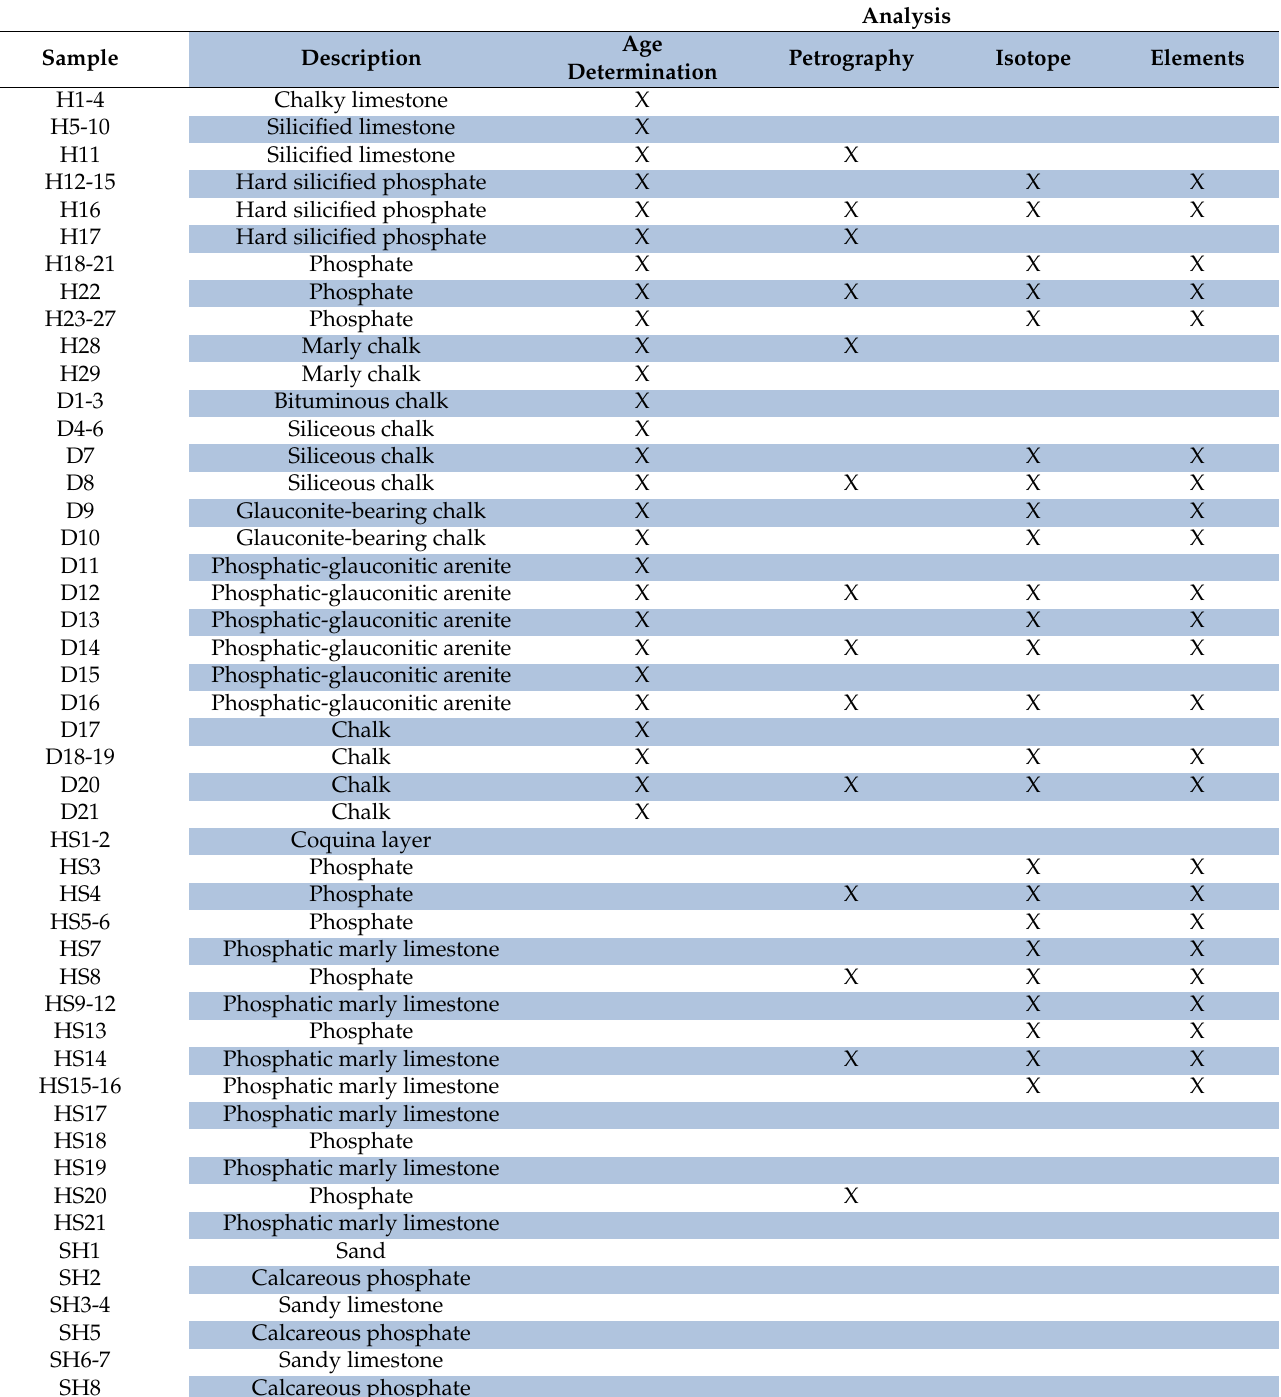
Table 1. Samples and the related analysis in this